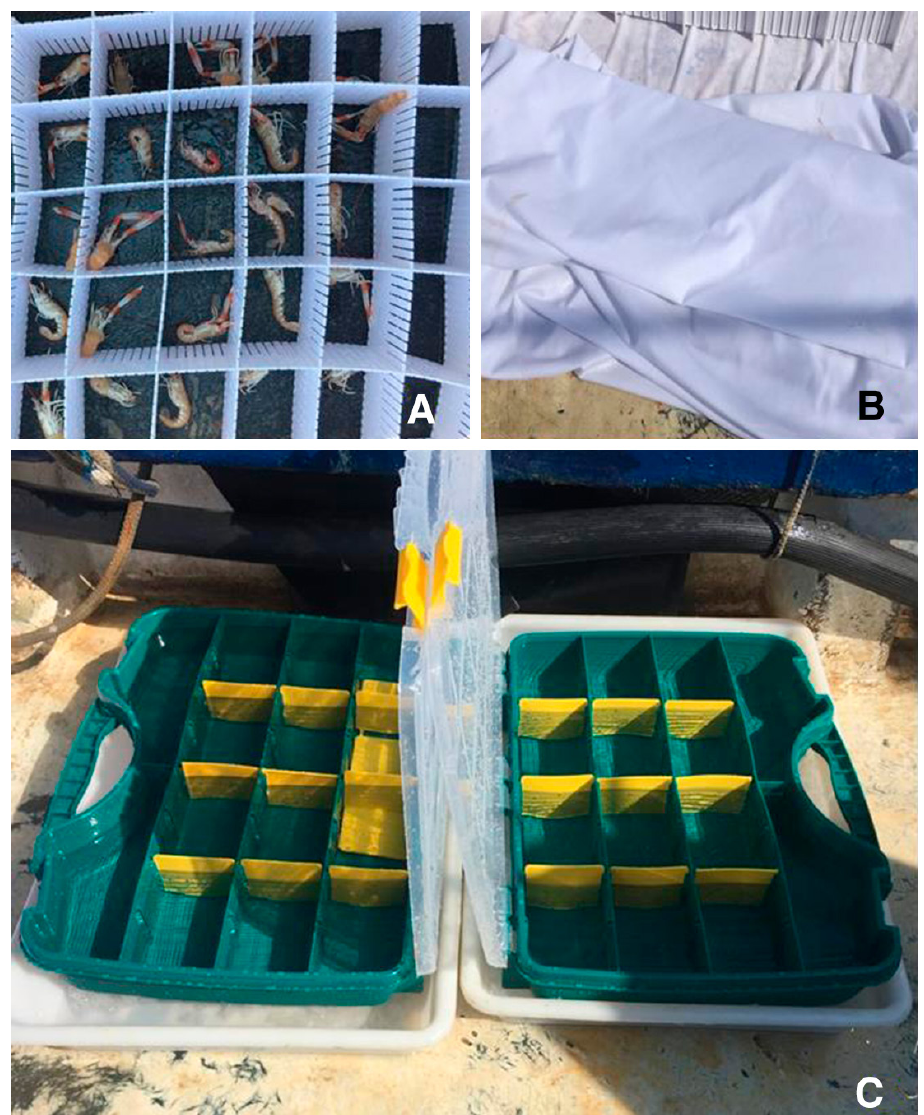
Fig. 2. – Control and treatment configuration; A, control; B, white cloth used in treatment 1; C, treatment